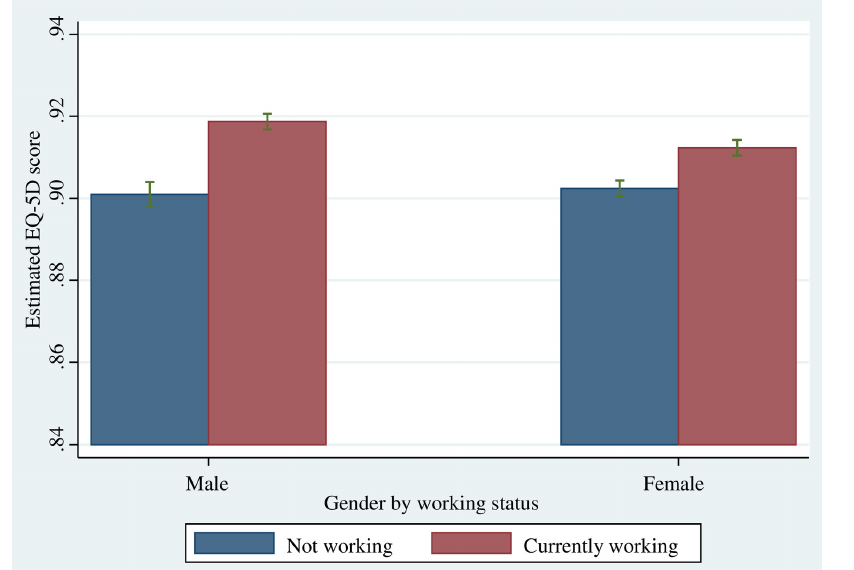
Fig 1. Relationship between quality of life and work status by gender.